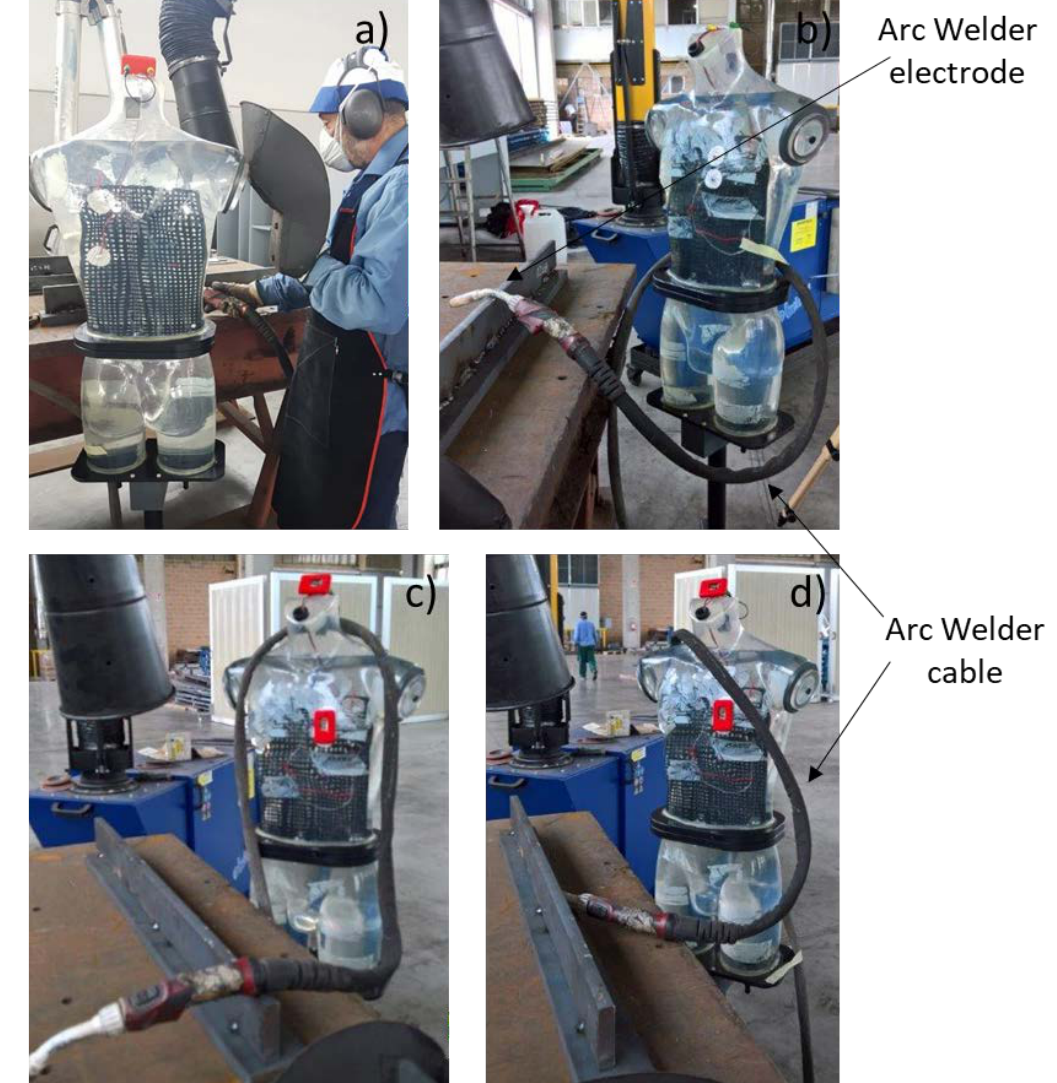
Figure 4. The four configurations adopted for testing the arc welder: ( a ) The cable raised from the floor next to the human torso-shaped phantom till reaching the work table; ( b ) the cable was fixed around the belt of the phantom; ( c ) the cable was placed over both shoulders of the phantom; ( d ) the cable was placed over one shoulder of the phantom. The support of a skilled worker (reported only in ( a )) was granted during each configuration tested to operate the arc welder.